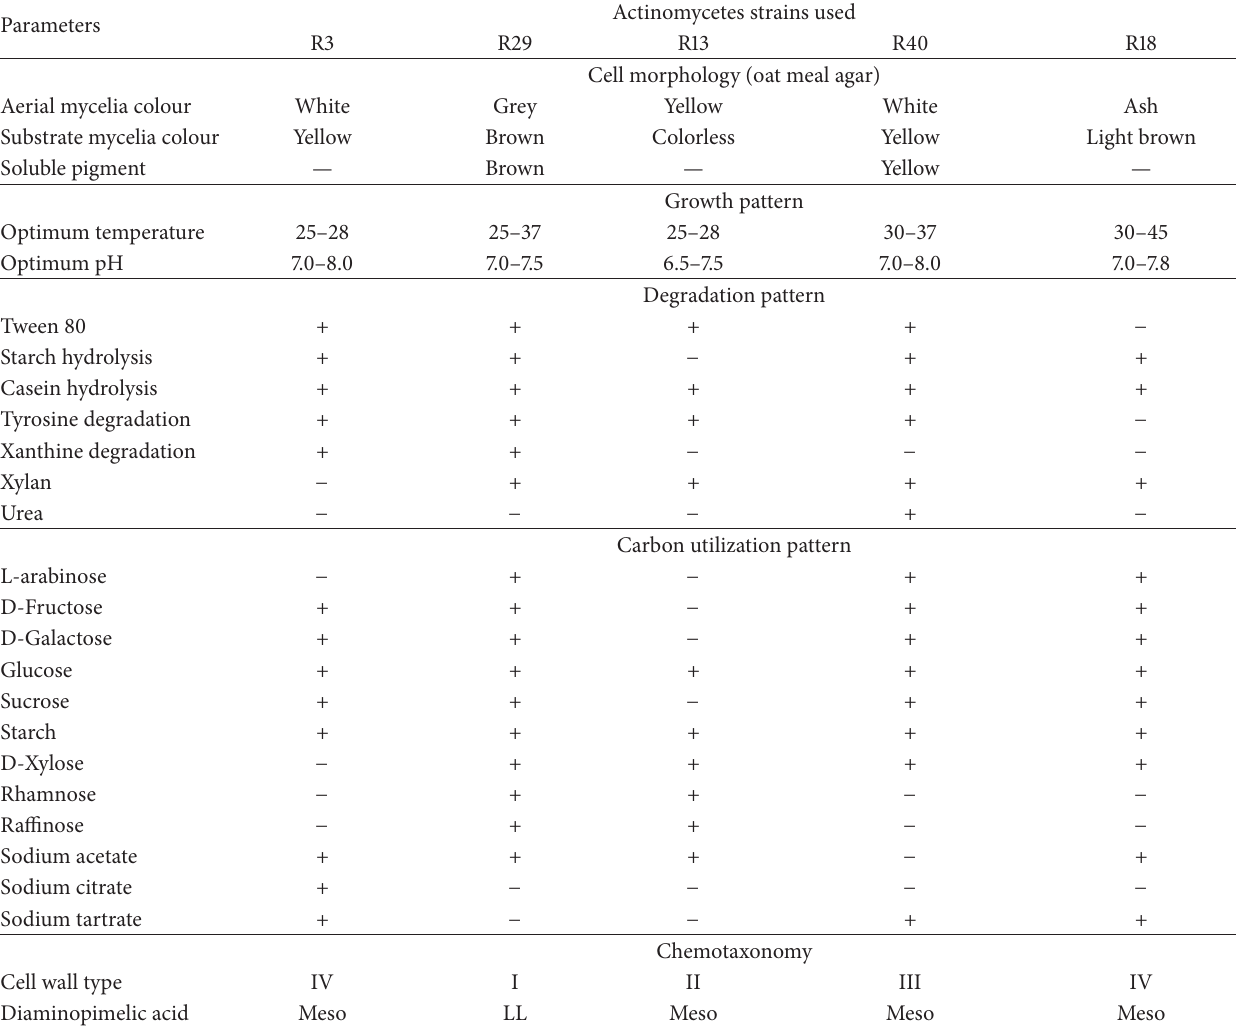
Table 1: Cultural, biochemical, and chemotaxonomic characterization of cellular